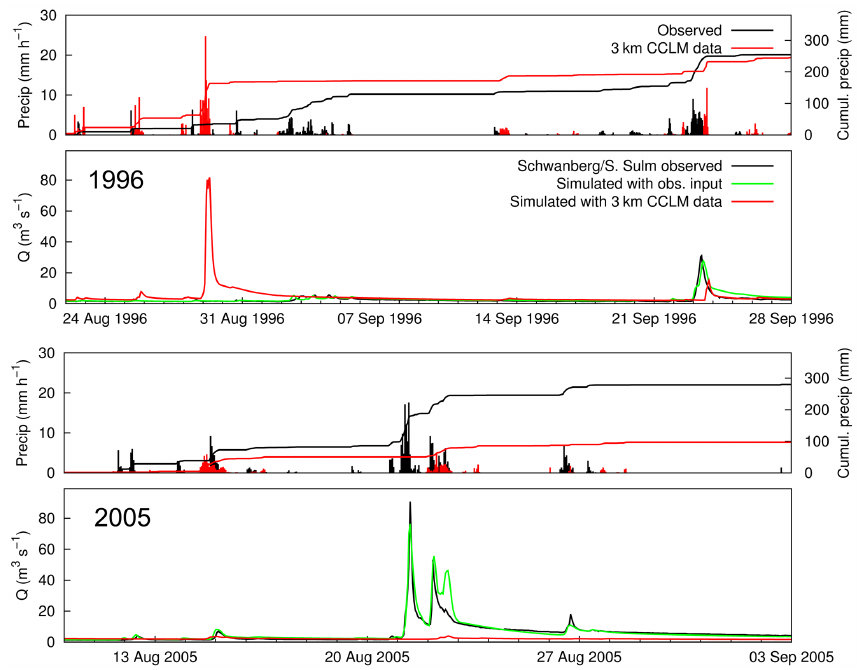
Figure 9. Example of two events (August 1996, above, and August 2005, below, in each case plotted with catchment precipitation above the run-off) simulated with raw CCLM 3km data compared to the simulation with observed input and observed run-off data for the Schwanberg